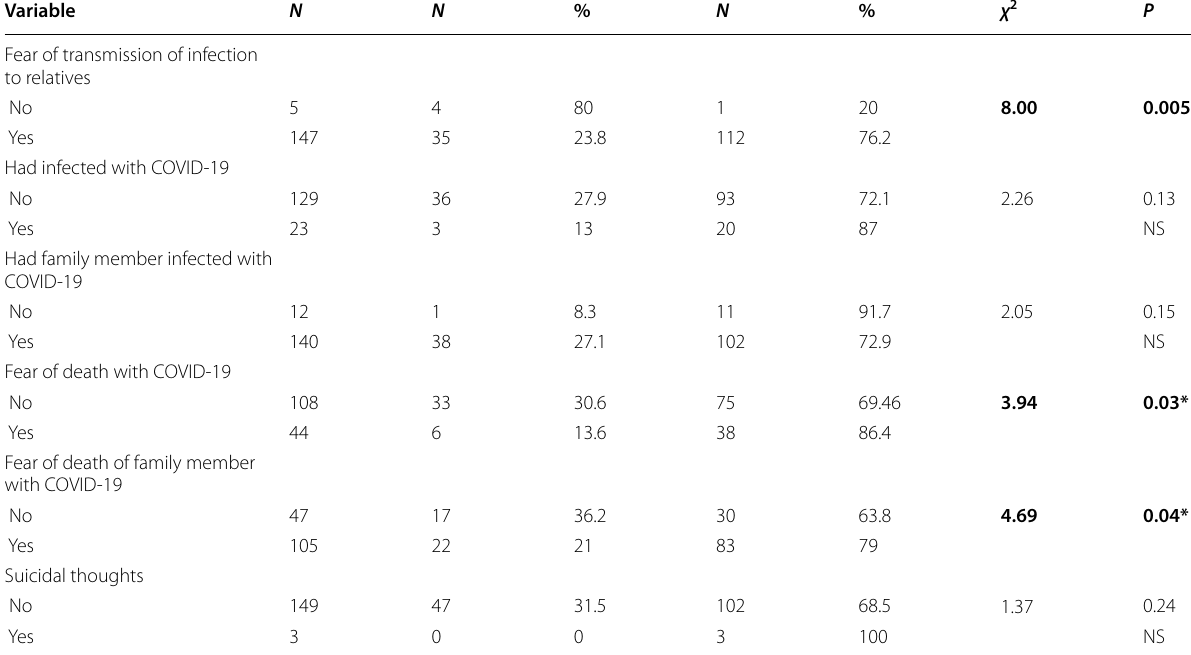
Table 4 Binary logistic regression analysis for predictors of major depression disorder according to SCID-1 among the studied group